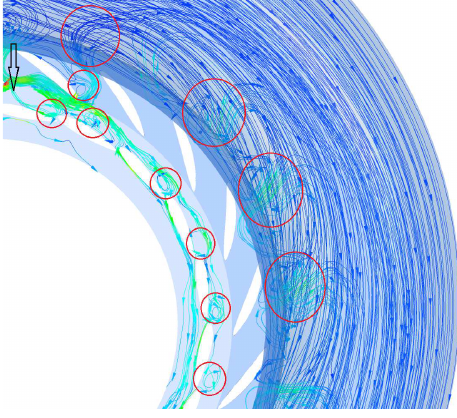
Figure 26. Representation of the streamlines in the volute, stay vane and guide vane domains at T f =